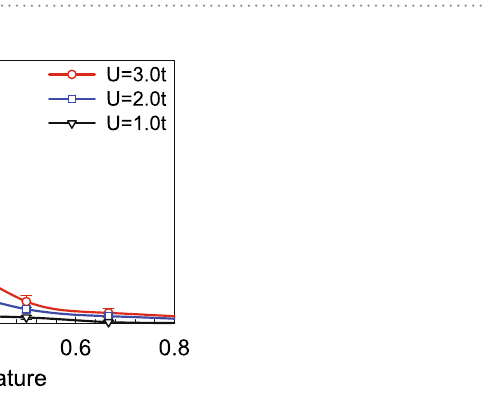
Figure 6. ( a ) The edge χ as a function of temperature at δ = 0.02 for different U , and the uniform χ B for U = 2.0 t is also present. ( b ) The spin correlation as a function of the site index along the edge for U = 2.0 t at δ = 0.02 and δ = 0.04, and U = 1.0 t at δ = 0.02.